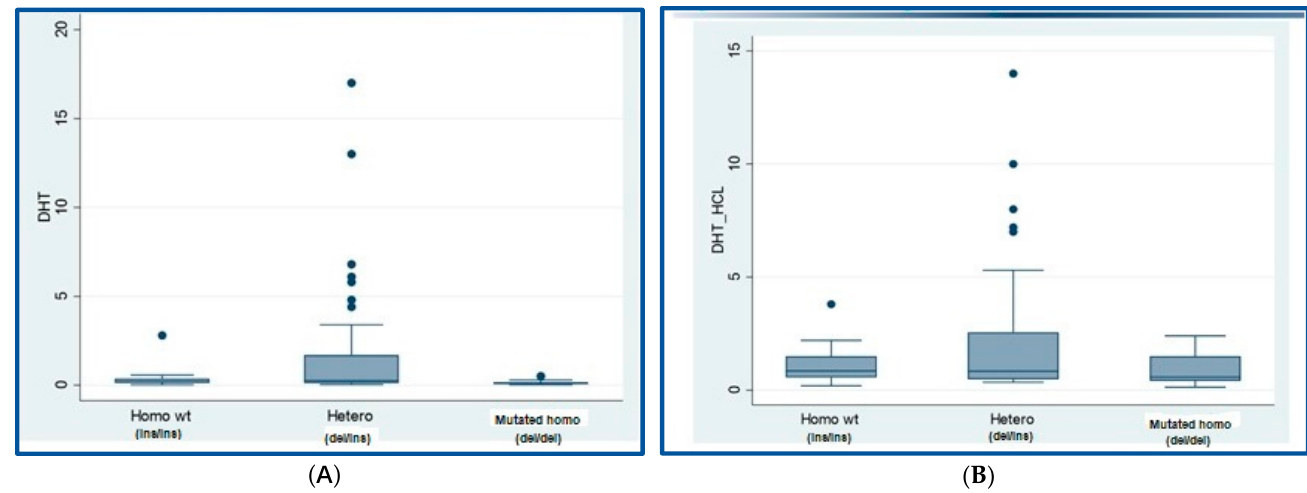
Figure 2. Distribution of the androgenic activity expressed in DHT equivalents in urine measured by AR CALUX ® for each polymorphic population ( A ) without and ( B ) with hydrolysis. In all cases, the data correspond to the period C1.